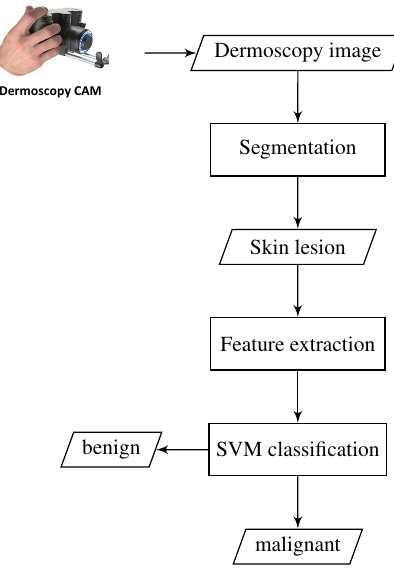
Figure 1. A general block diagram of computerized melanoma skin cancer Fig. 2 . A general block diagram of computerized melanoma skin cancer detection.